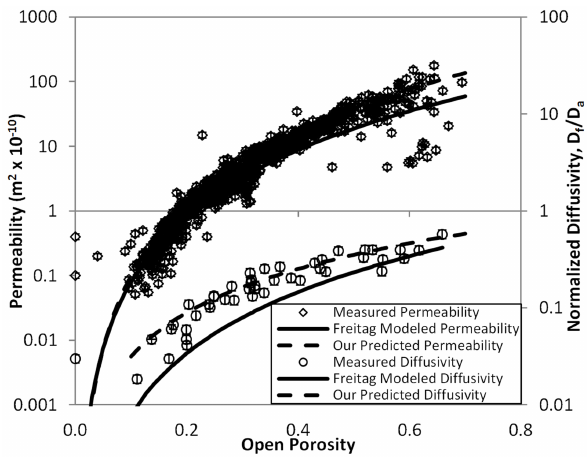
Fig. 4. Logarithmic scale of measured permeability and normal- ized diffusivity plotted against porosity, showing the permeabil- ity and diffusivity formulas developed by Freitag et al. (2002) us- ing lattice-Boltzmann modeling, and our parameterizations based solely on measurements: for permeability, k = 10 − 7 . 29 m 2 φ 3 . 71 o and R 2 = 0.66, and for diffusivity, D f / D a = φ m with m = 1.5. R 2 =